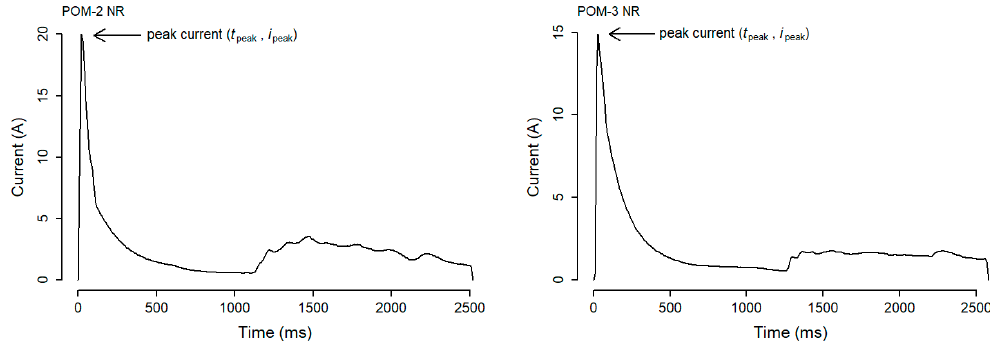
Figure 3. Current draw signal of actuation events for point-operating machines POM-2 (peak current ≈ 20A) and POM-3 (peak current ≈ 15A) in the NR direction.